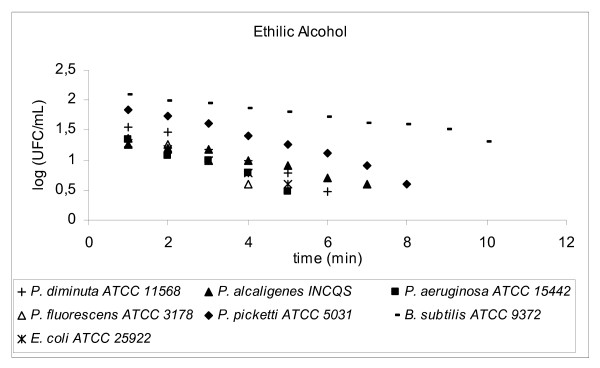
Graphic representation of the standard and in house microorganism reduction against different sanitizers.